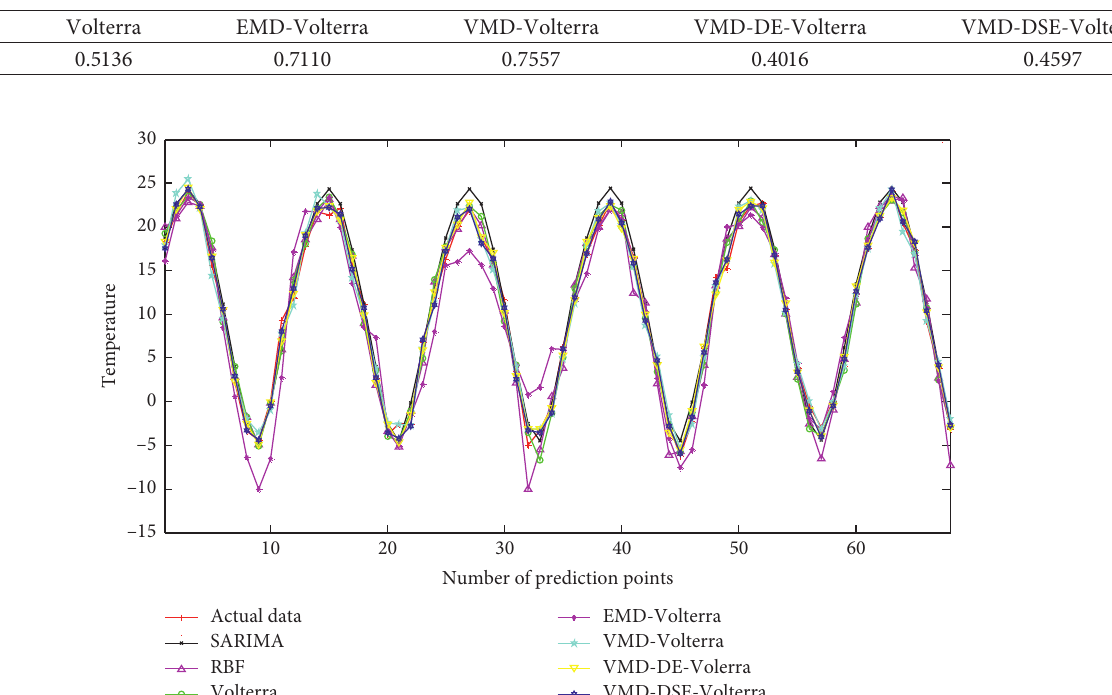
Table 4: Running time of each prediction model.